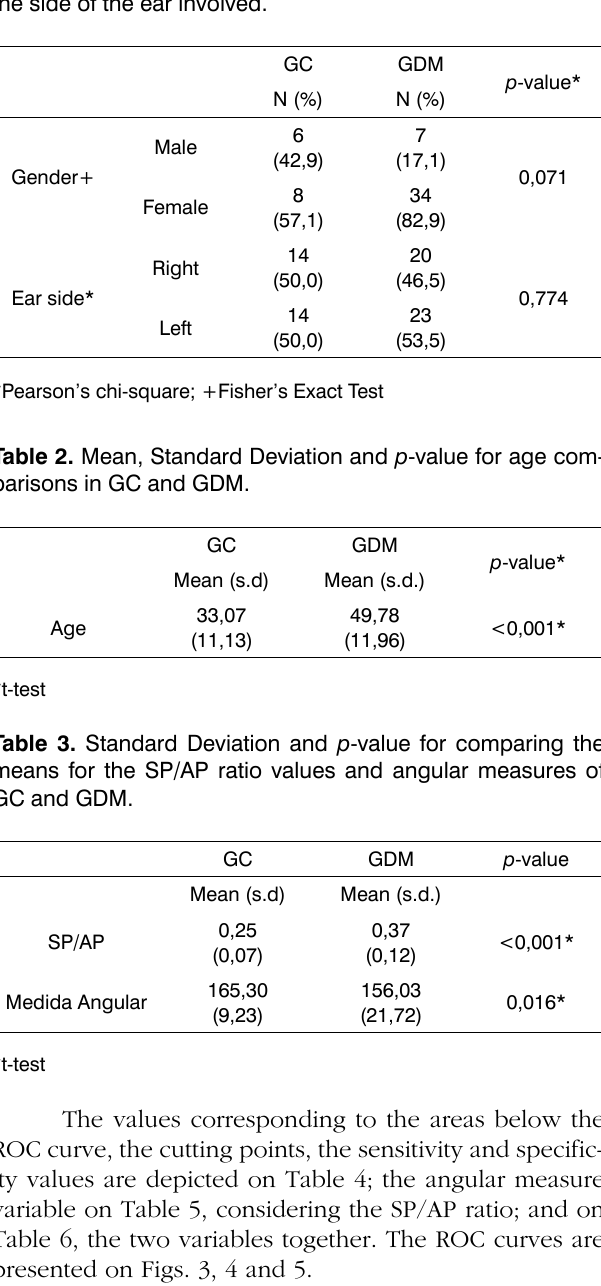
Table 1. Frequency and percentage distribution of the ears allocated to groups GC and GDM according to gender and the side of the ear involved.